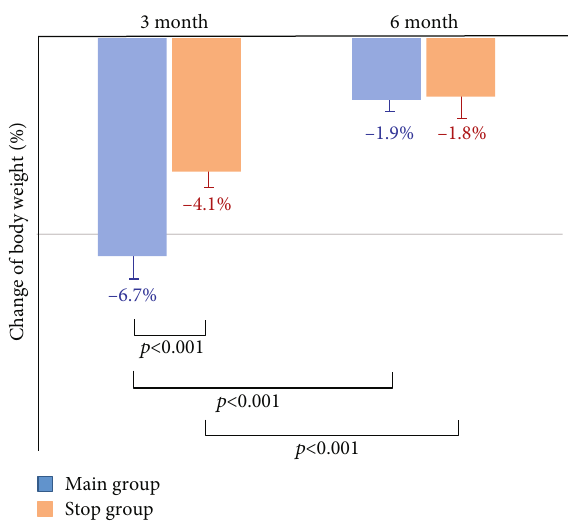
Figure 2: Weight change according to the discontinuation of liraglutide.